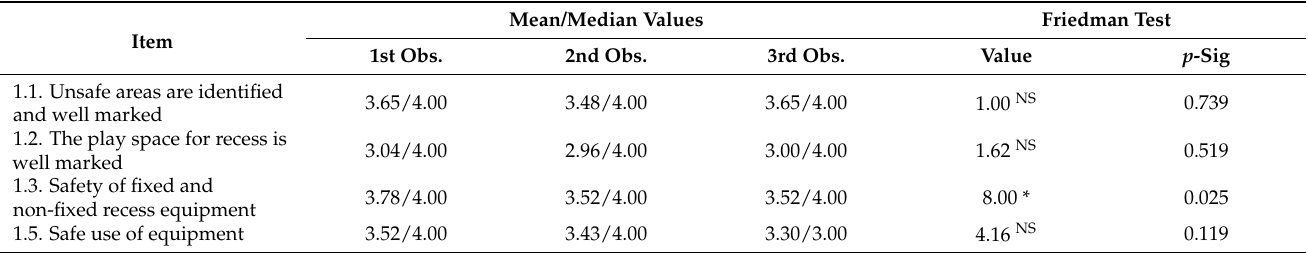
Table 2. Comparative analysis of observations. Items from D1: Safety and structure. GRF-OT.Cat. n = 23 schools.